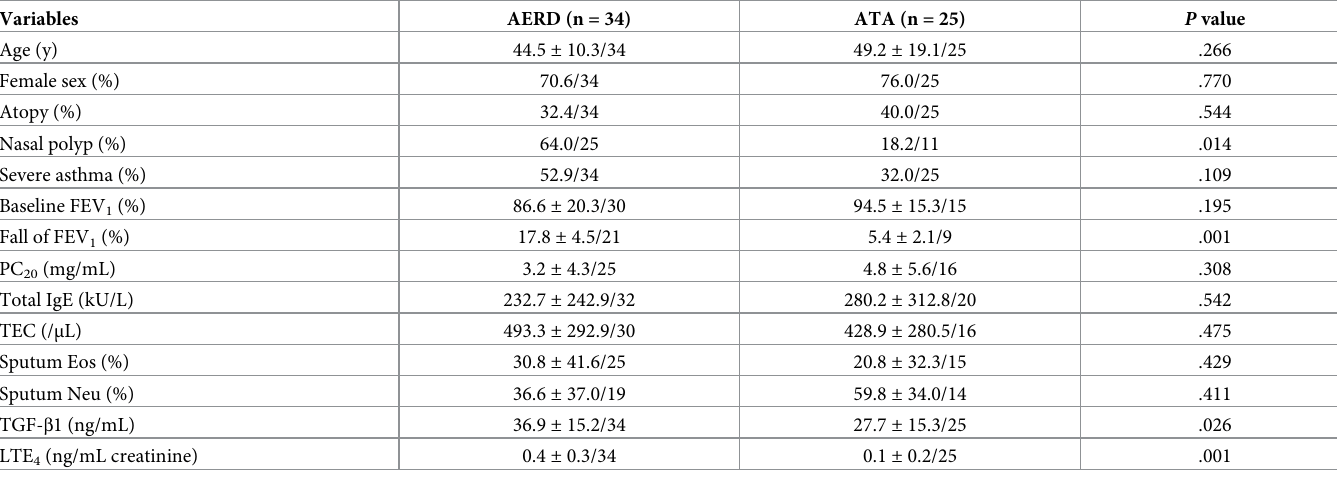
Table 3. Demographic data of the study subjects enrolled in the second